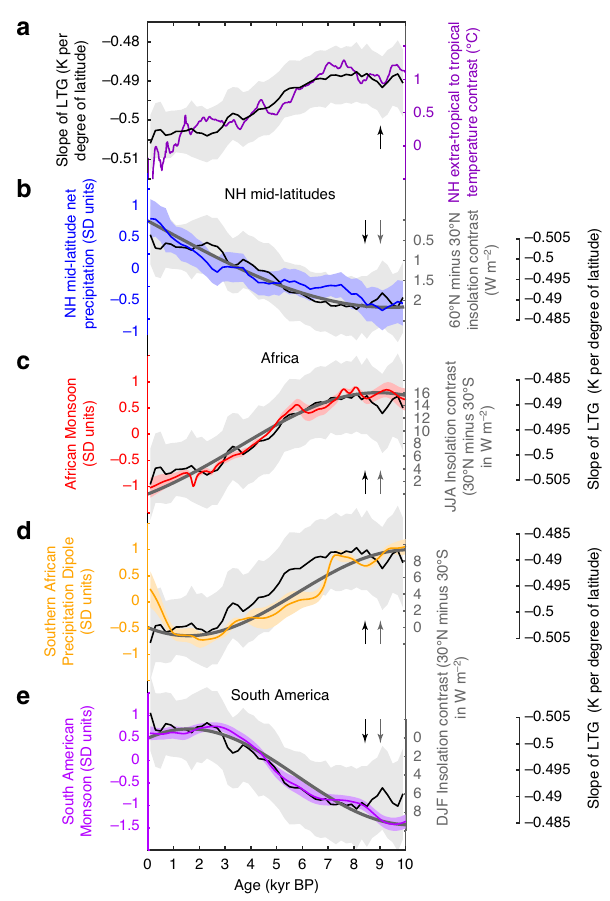
Fig. 5 Comparison of Holocene inter-hemispheric hydroclimate variations with changes in the latitudinal energy balance. In all panels, changes in insolation contrast are given relative to present and arrows indicate the direction of an increasing insolation contrast or a weaker Northern Hemisphere latitudinal temperature gradient. a Reconstructed slope of the Northern Hemisphere latitudinal temperature gradient (LTG) (black, see ref. 5 ) between the low-latitudes and high-latitudes, and the temperature contrast (purple, see ref. 18 ) calculated from zonal averages for the tropical region (low-latitudes) (30°S to 30°N) and the Northern Hemisphere extratropics (>30°N). b Standardised Northern Hemisphere (NH) mid- latitude net precipitation (blue) reconstructed by see ref. 3 and the annual mean insolation contrast between 60°N and 30°N calculated from mean monthly insolation values (bold grey line). A positive insolation contrast indicates that the Northern Hemisphere higher latitudes received more insolation than the Northern Hemisphere lower latitudes relative to present. c Standardised precipitation changes associated with the African Monsoon (red) and the mean interhemispheric insolation contrast between 30°N and 30°S for June to August (JJA) (bold grey line). A positive insolation contrast indicates that Northern Hemisphere received more insolation than the Southern Hemisphere compared to present. d Standardised mode of southern African precipitation changes (yellow) and the mean interhemispheric insolation contrast between 30°N and 30°S for December to February (DJF) (bold grey line). e Standardised precipitation changes associated with the South American Monsoon (orange) and the mean interhemispheric insolation contrast between 30°N and 30°S for December to February (DJF) (bold grey line). The black line illustrates the slope of the Northern Hemisphere latitudinal temperature gradient illustrated in a . Shading in panels a-e indicates 1-sigma standard deviation (see ‘ Methods'